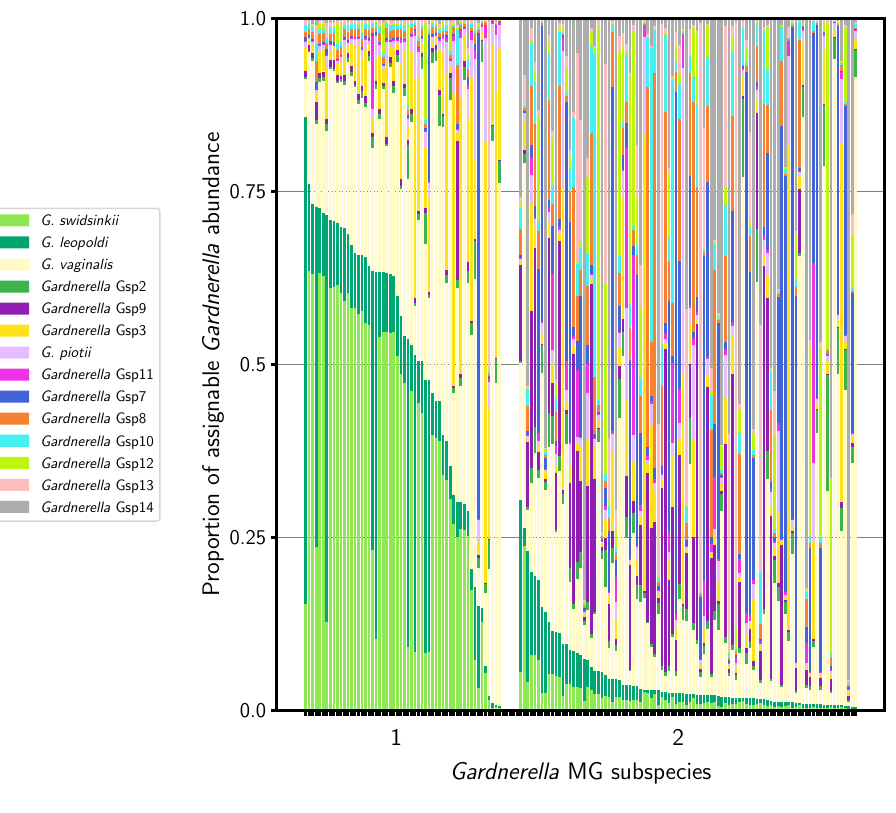
Figure 2. Proportions of assignable Gardnerella abundance in two distinct profiles of metagenomic subspecies of Gardnerella present in vaginal specimens collected between 16–20 weeks and 24–36 weeks, N =